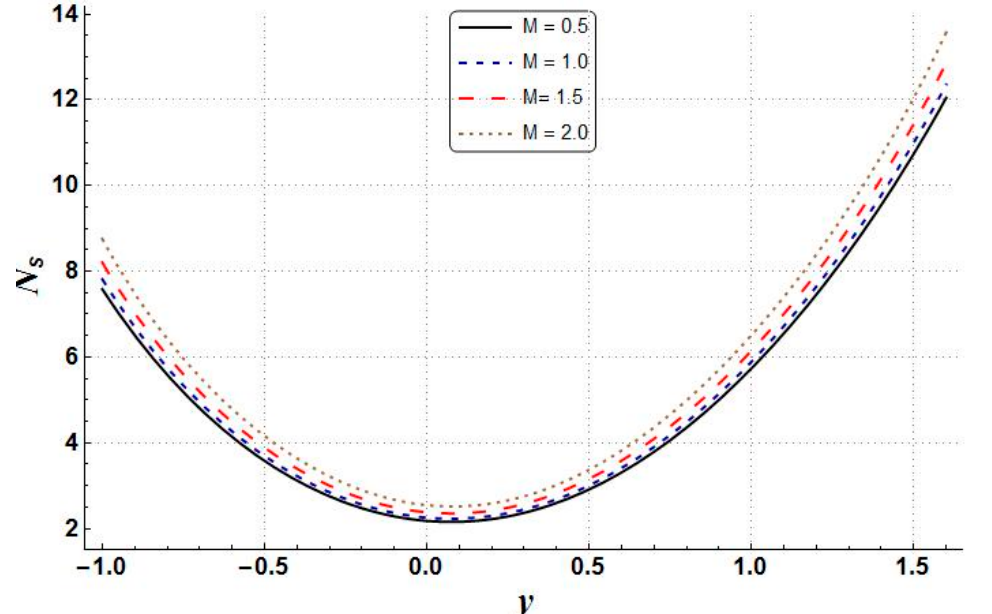
N through changing values of , where